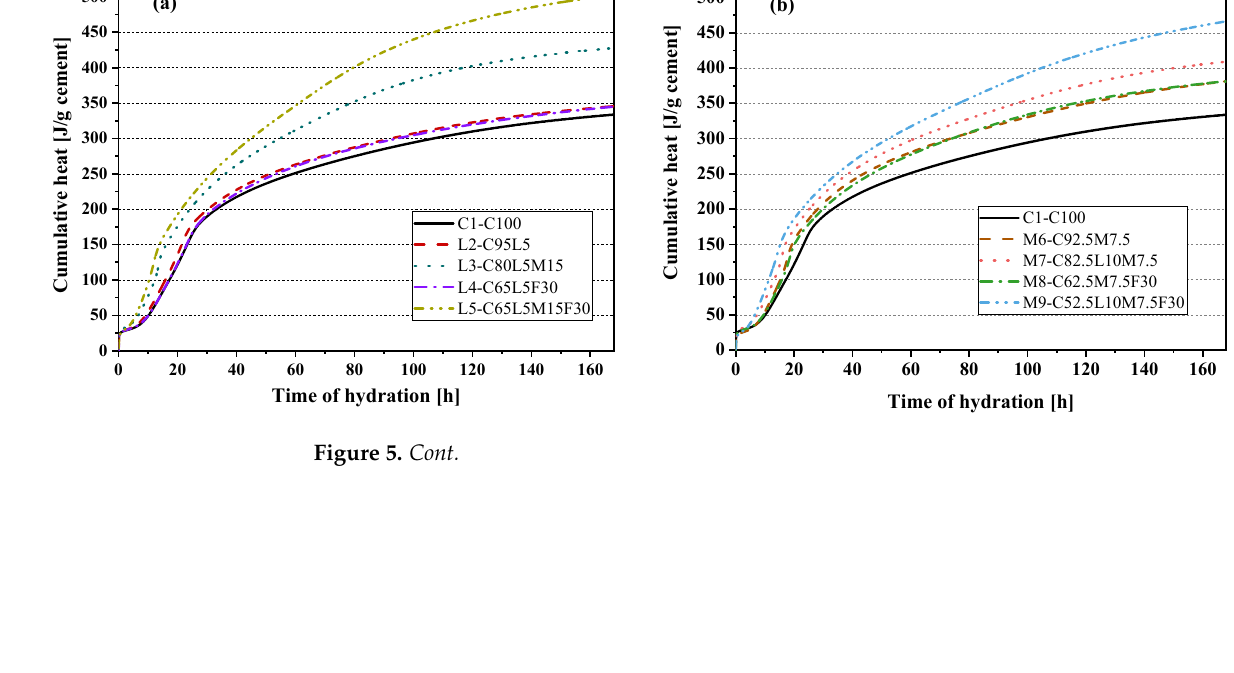
Figure 5. Cumulative hydration heat normalized to cement content: ( a ) the control specimen and LS system; ( b ) the control specimen and MK system; ( c ) the control specimen and FA system. 3.3. Compressive Strength Figure 6 shows the change in compressive strength of the paste at 3, 7, and 28 days. Generally, LS, as an alternative material added to the blended paste, had a diluting effect and a nucleation effect [40]. Therefore, it is expected that in the early stage of hydration, LS can provide the compressive strength of the blended paste. As shown in Figure 6a, the compressive strength of L2(C95L5) blended paste with 5% LS added in the early stage (i.e., 3, 7 days) was equivalent to that of pure cement paste; when the curing age reached 28 days, the compressive strength of mixed L2(C95L5) exceeded that of C1(C100), reach ‐ ing 56.59 MPa. In Figure 6b, the blended paste M6(C92.5M7.5) with 7.5% MK added ex ‐ hibited compressive strength equivalent to that of the pure cement paste C1(C100) at var ‐ ious ages. Previous studies have also shown that LS and MK have a synergic effect, and LS can interact chemically with aluminate [27,41]. The compressive strength of L3(C80L5M15) blended paste at 3, 7, and 28 days was slightly higher than that of C1(C100) paste. The M7(C82.5L10M7.5) blended paste showed a similar strength to C1(C100) in the early stage (i.e., 3, 7 days). The difference of strengths between the two specimens was less than 2.7 MPa. At 28 days, the compressive strength of M7(C82.5L10M7.5) was 21.5% lower than that of C1(C100). This may be due to the large amount of LS added [42]. Observing Figure 6a,b, it can be seen that the amount of replacement alternative materials was